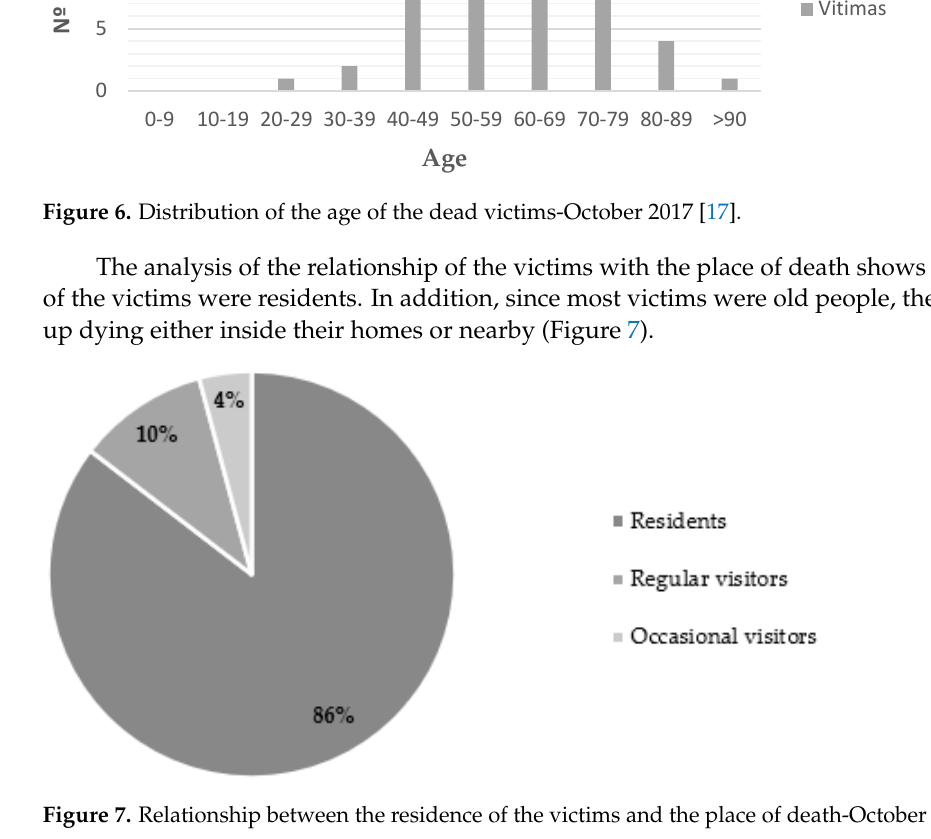
Figure 7. Relationship between the residence of the victims and the place of death-October 2017 [17] . The distribution of distances from the place of death to the home was more hetero- geneous in the October fire (Figure 8), allowing us to conclude that there were different circumstances and decisions by the victims.